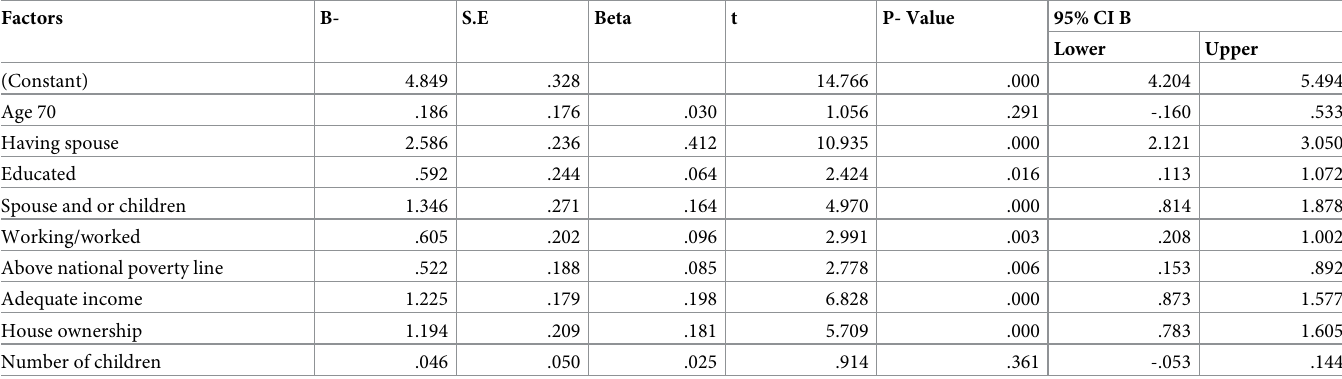
Table 5. Contributing factors of Social participation domain of the QOL of